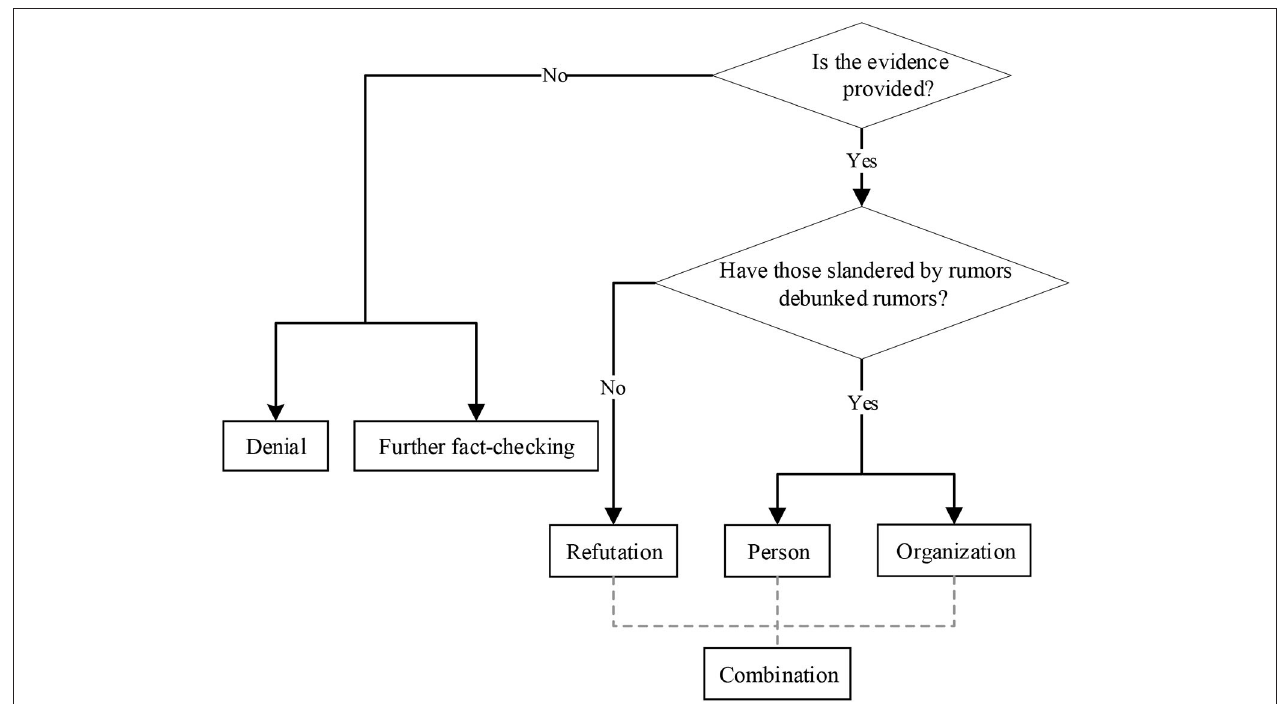
FIGURE 1 | Classification flowchart of debunking